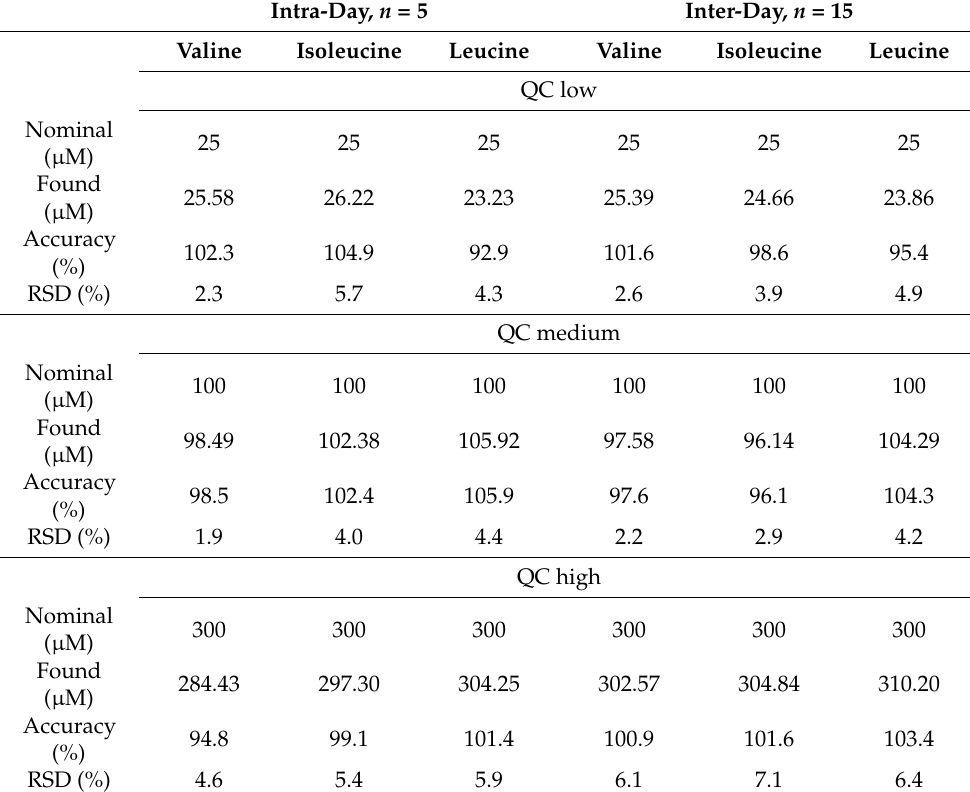
Table 8. Accuracy and precision data of the QC